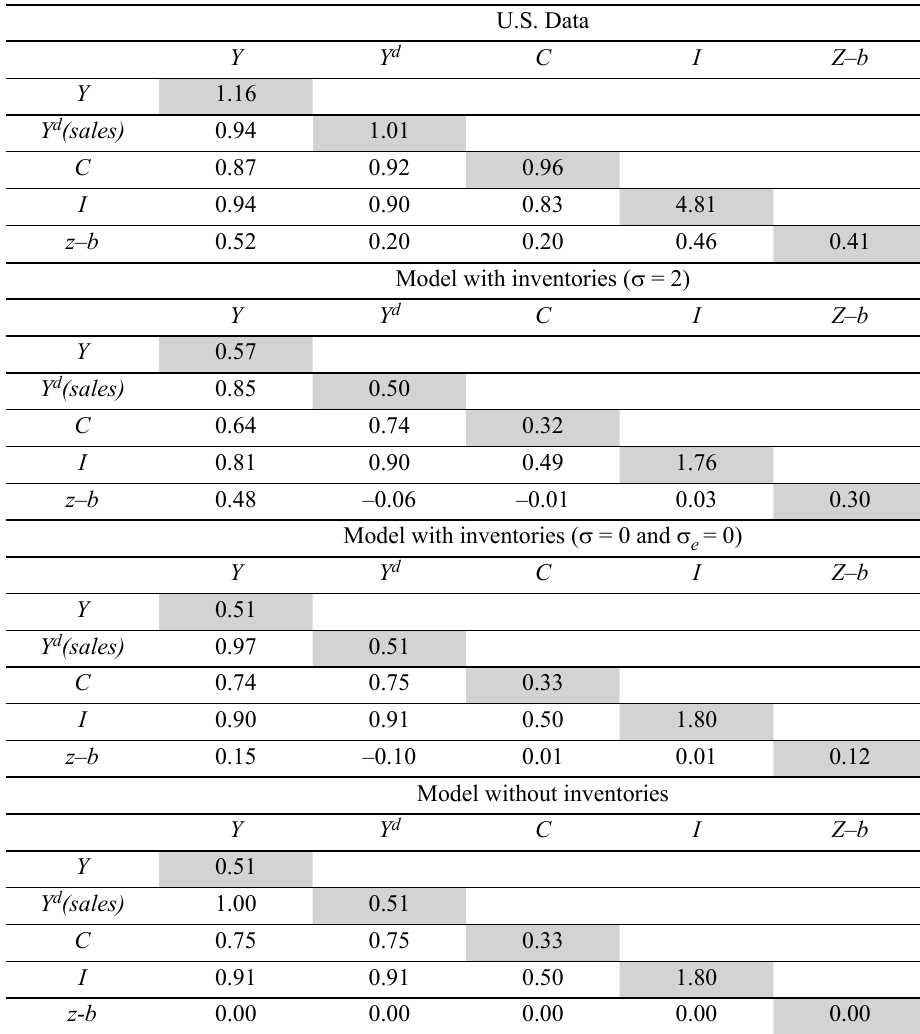
Table 2. Standard deviation and correlation